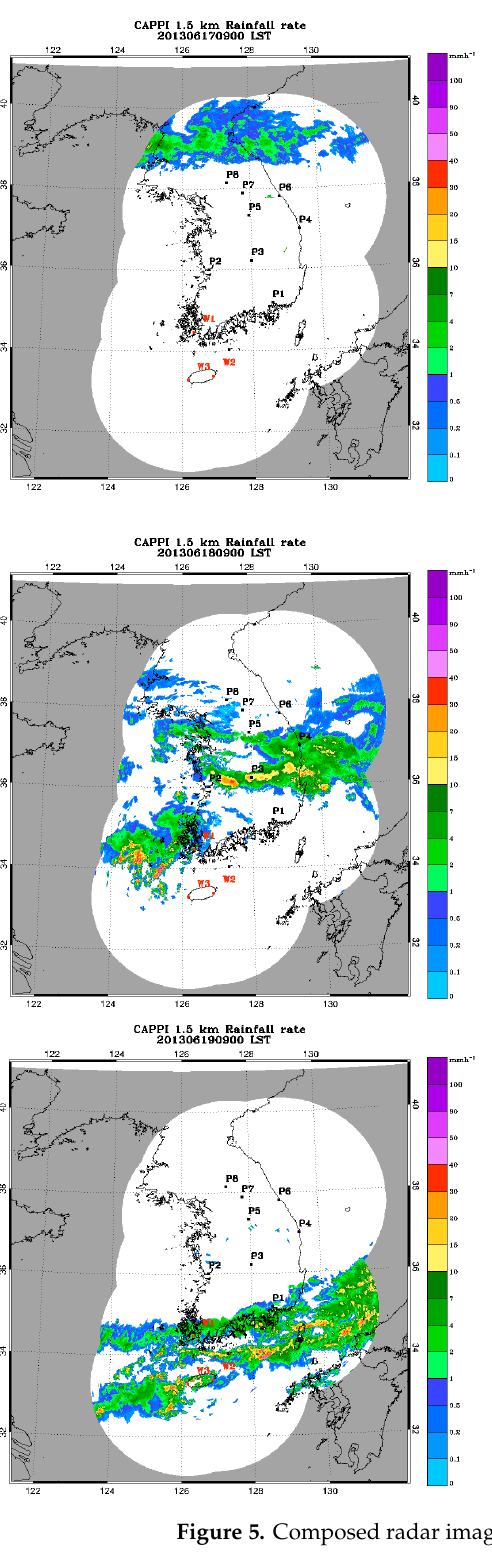
Figure 3. Surface weather maps show Jangma front movement. The green line and the hatched zone indicate the area where the dew point temperature is 20 °C or higher.